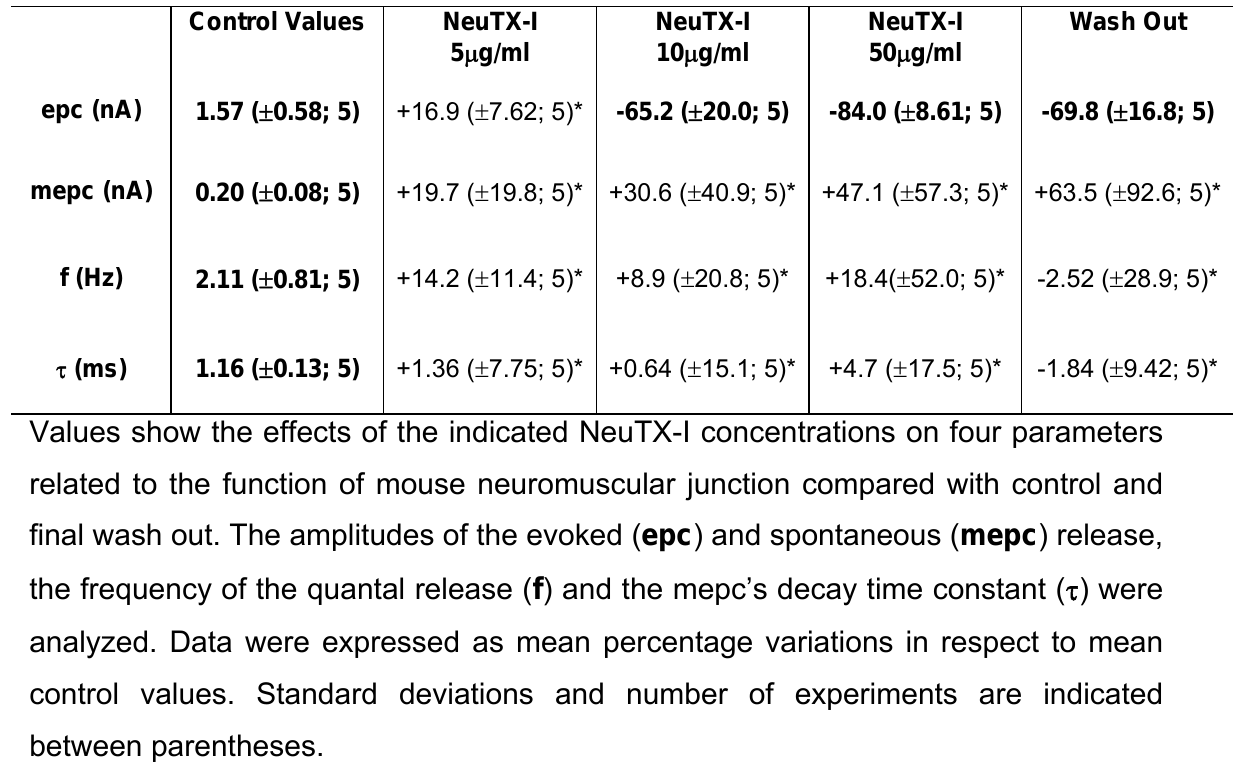
Table 1. Effects of NeuTX-I on mouse neuromuscular